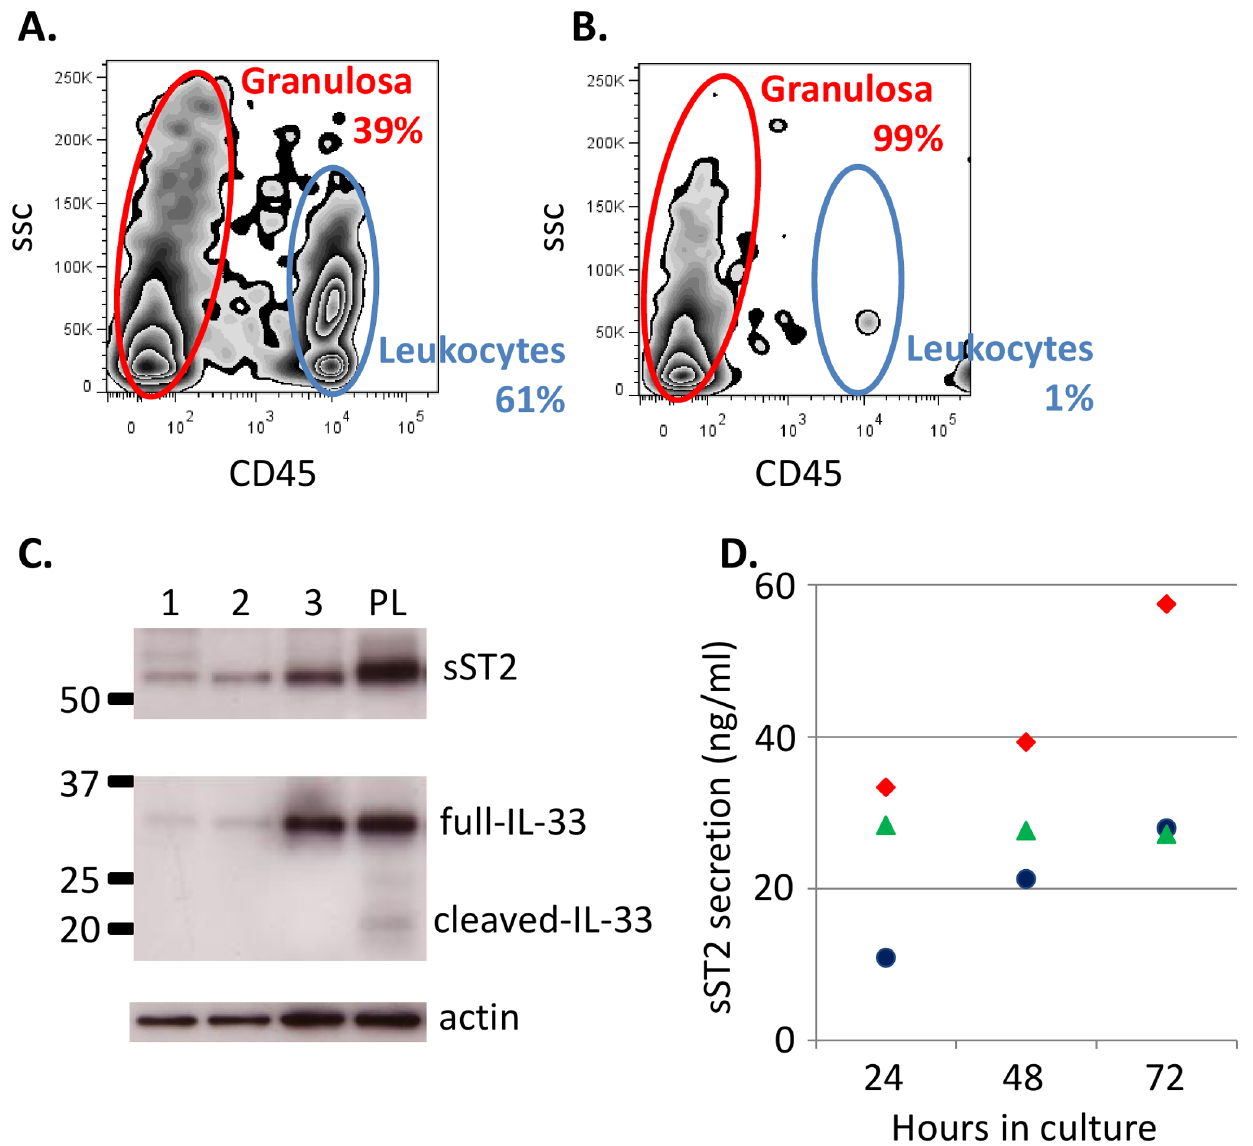
Figure 3. sST2 is secreted by granulosa cells. Aspirated FFs contained a mixture of granulosa cells (CD45 negative) and leukocytes (CD45 positive) (A). Leukocytes were removed by filtration through a 70 m m filter which retained granulosa cells, resulting in . 98% purity granulosa cells (B). Full length IL-33 and ST2 in the purified granulosa preparations can be detected by immunoblotting from three patients (1, 2, 3), PL=placenta lysate positive control (C). Purified granulosa secrete sST2 in culture (D), granulosa cell preparations from three patients (red diamonds, green triangles, blue circles) were cultured for up to 72 hours and supernatants assayed by ELISA for sST2. Growth media contained no detectable sST2.